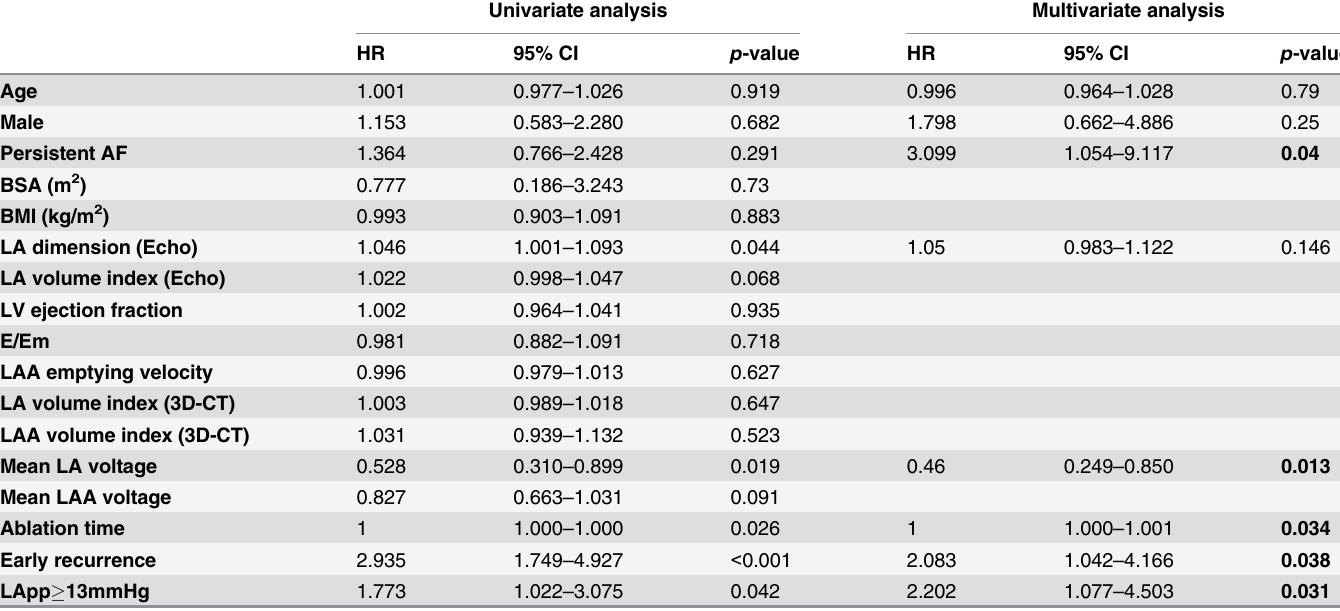
Table 4. Multivariate Cox regression analysis of clinical AF recurrence after